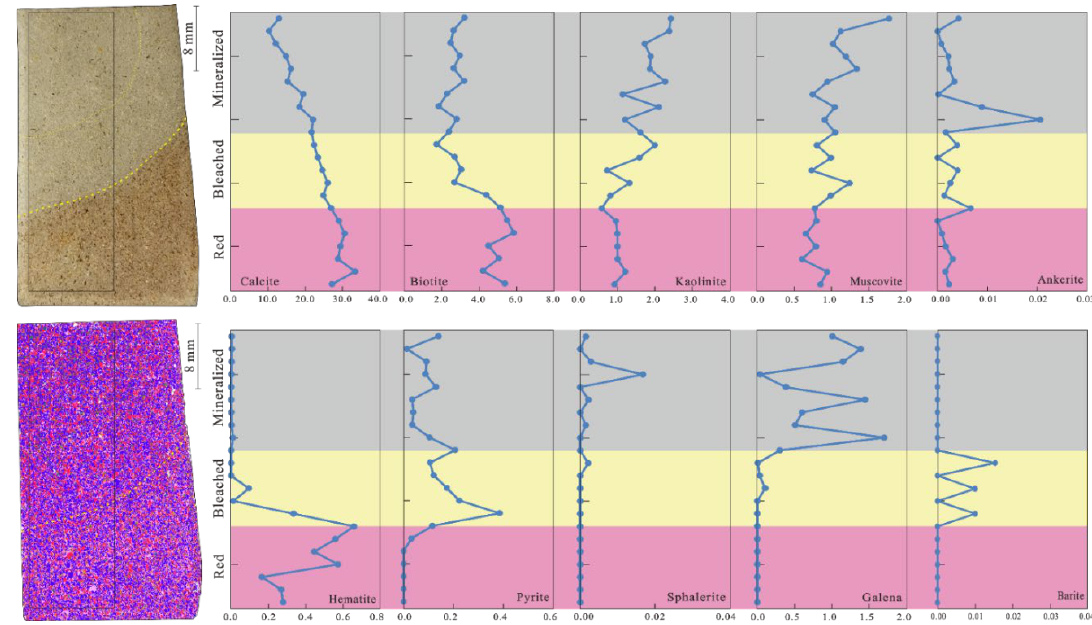
Figure 7. The mineral identification and mapping of red and bleached sandstone at the same sedi- mentary layer from the fifth member of the Lower Cretaceous Kezilesu Group used by TIMA. The distributions of hematite ( a ), biotite ( b ), calcite ( c ), pyrite ( d ), kaolinite ( e ), barite ( f ), ankerite ( g ) and whole phases ( h ) are shown in the red, bleached, and mineralized zones. Barite locally replaced by pyrite in the bleached front zone was shown in Figure ( f1 ), and fine-grained pyrite locally replaced by coarse-grained galena in the leached, slightly mineralized zone was shown in Figure ( d1 ).